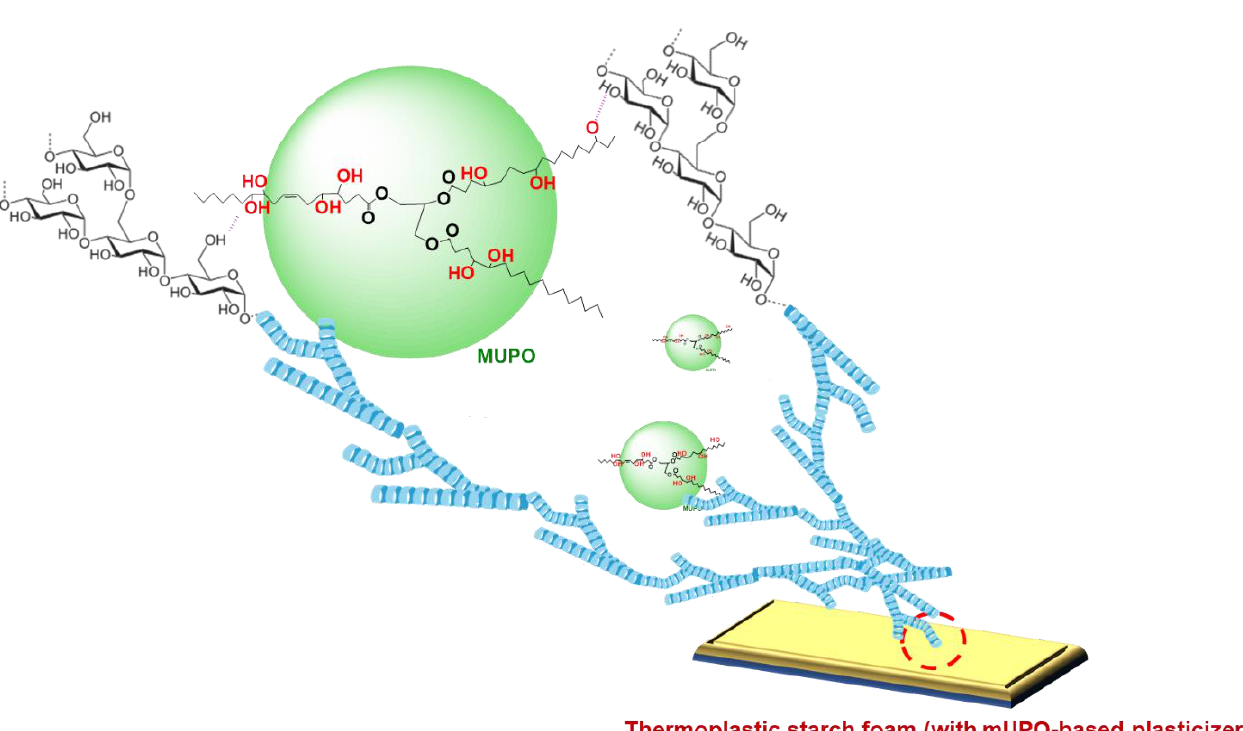
Figure 9. The possibility of the action of the mUPO on the thermoplastic non-glutinous starch foam.